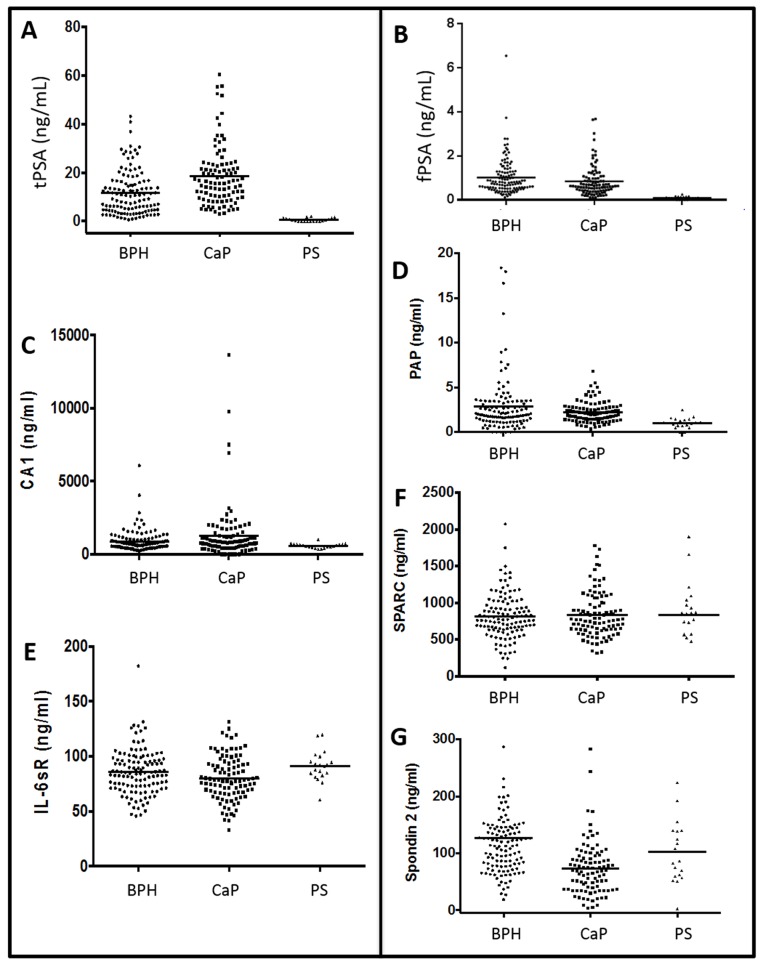
Serum Data.Raw values with means for BPH, CaP, and post-surgery (PS) samples. Biomarkers include tPSA (A), fPSA(B), CA1 (C), PAP (D), IL6-sr (E), SPARC (F), and SPON2 (G). Horizontal lines indicate mean values.